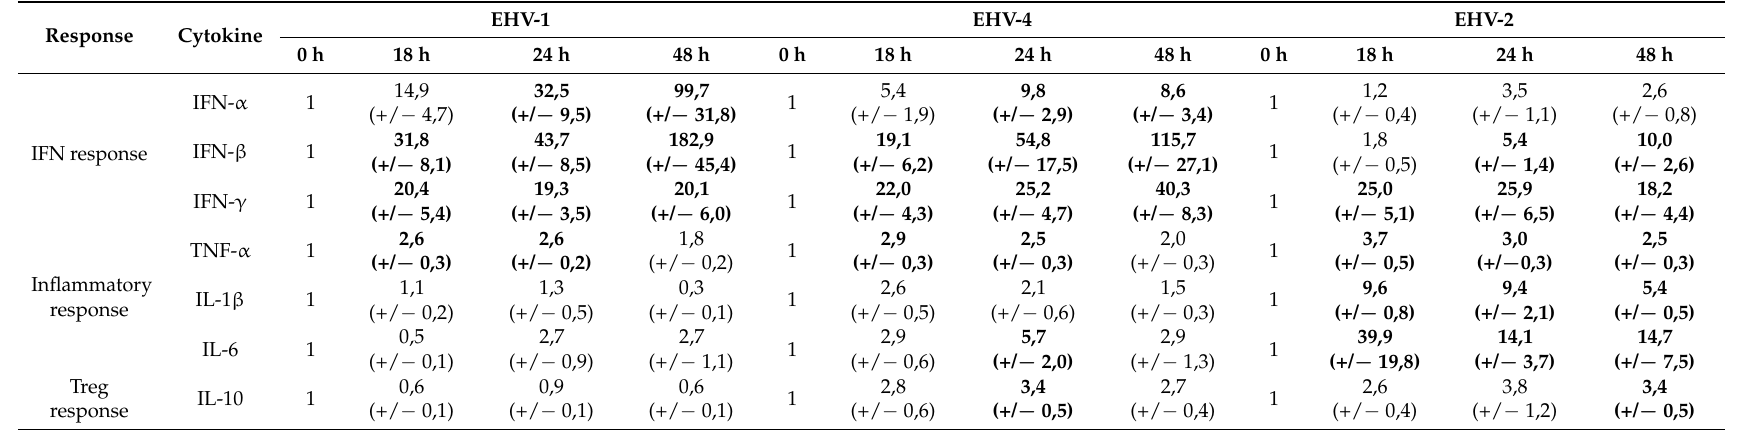
Table 2. Cytokine (IFN- α , IFN- β , IFN- γ , TNF- α , IL-1 β , IL-6, and IL-10) mRNA expression measured by real-time PCR in PBMC at 18 h, 24 h, and 48 h, after EHV-1, EHV-4, and EHV-2 infection. n = 3 horses with 3 independent reverse-transcriptase PCR. Results are presented as the means ± SEM of the expression ratio (times-fold increase over the T 0 = 0 h). Significant differences from T 0 are indicating in bold ( p <